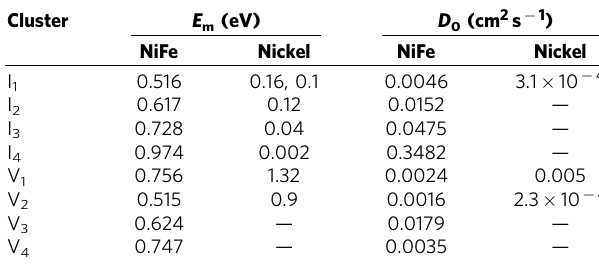
Table 1 | Migration energy barriers E m and exponential pre-factor D 0 of point defects (vacancy and interstitial) and their clusters in NiFe as compared with that in pure nickel 30,31,39 .